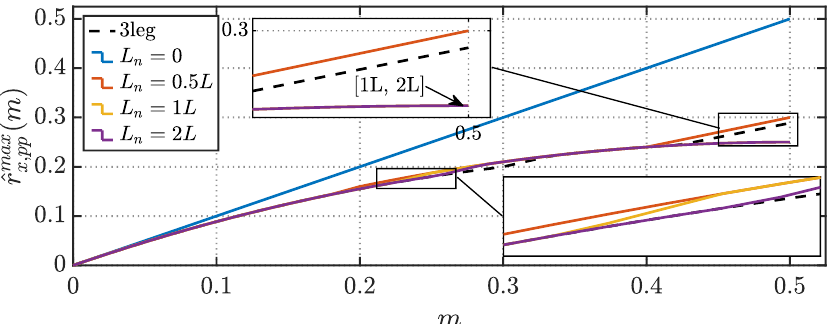
Figure 7. Maximum, normalized, peak-to-peak phase switching current ripple as a function of modulation index m at specific inductance values of a neutral line inductor.